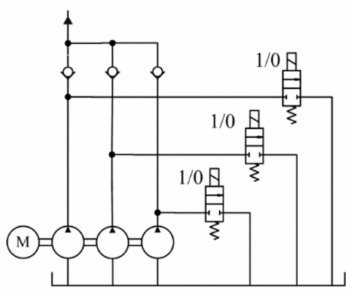
Figure 7. Parallel digital hydraulic